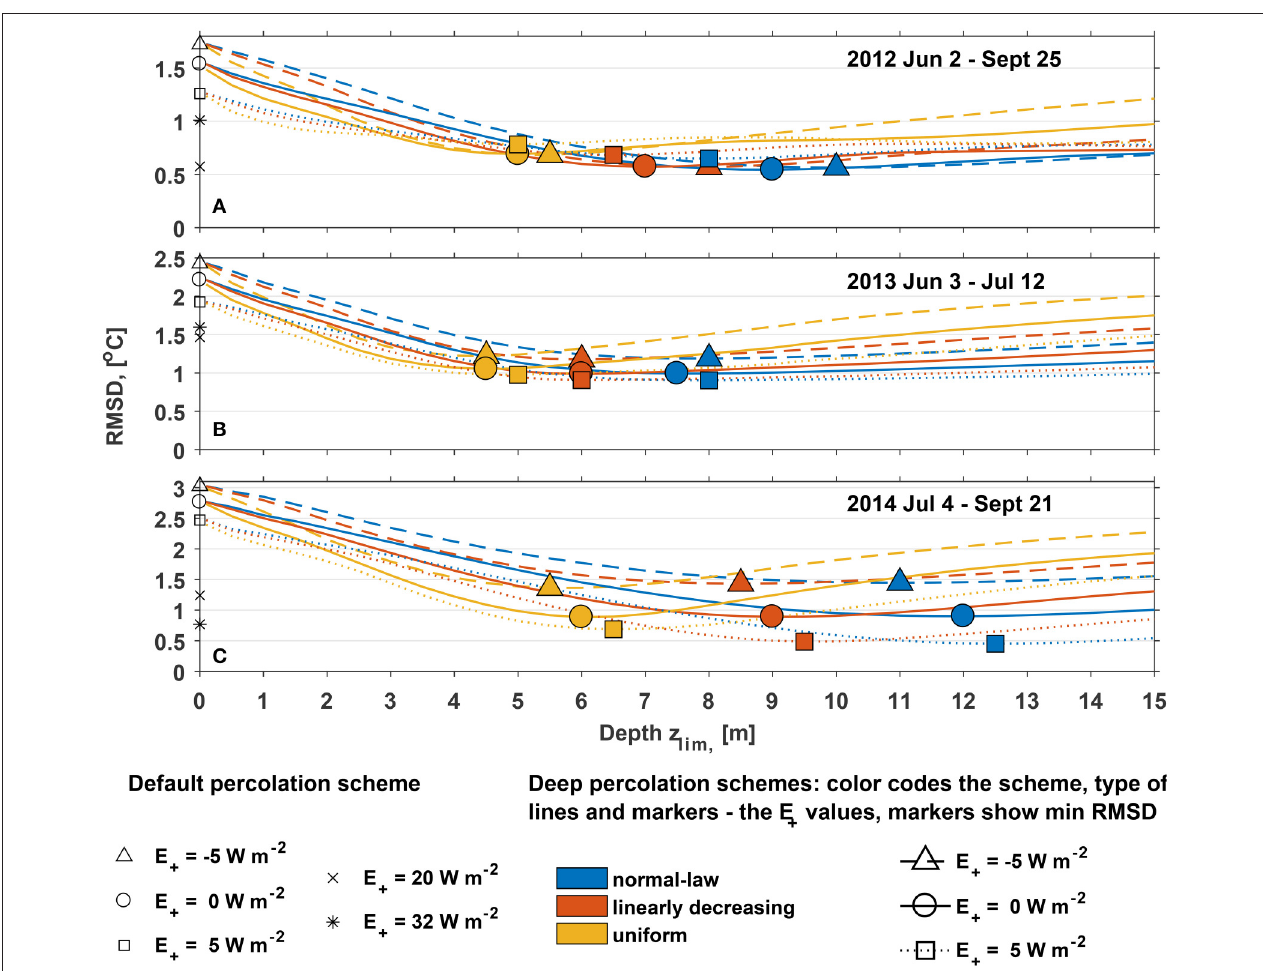
FIGURE 11 | Sensitivity of the RMSD between the simulated and measured summer subsurface temperature on the type of the infiltration scheme, depth z lim to which liquid water is allowed to infiltrate and parameter E + regulating the energy available for melt. (A) 2 June–25 September 2012; (B) 3 June–12 July 2013; (C) 4 July–21 September 2014. Note the difference in the limits of the vertical axis. Black markers in each panel show the RMSD for the default water infiltration scheme, blue color shows the results for “normal law,” red for the “linear” and yellow for the “uniform” infiltration laws. Markers show location of the f ( z lim ) functions. Type of the line and marker code tuning of the surface energy balance model: solid lines and circles for minima in RMSD for each of the RMSD = E 0 Wm − 2 , dashed lines and triangles for E 5 Wm − 2 and dotted lines and squares for E 5 Wm − 2 + = + = − + =